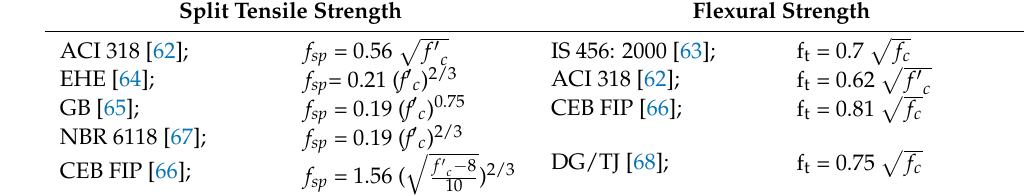
00.511.522.533.54